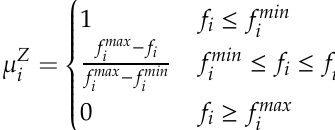
Figure 5. The Weibull distribution of the obtained voltage stability improvement (VSI) values around the mean in 50 trials.